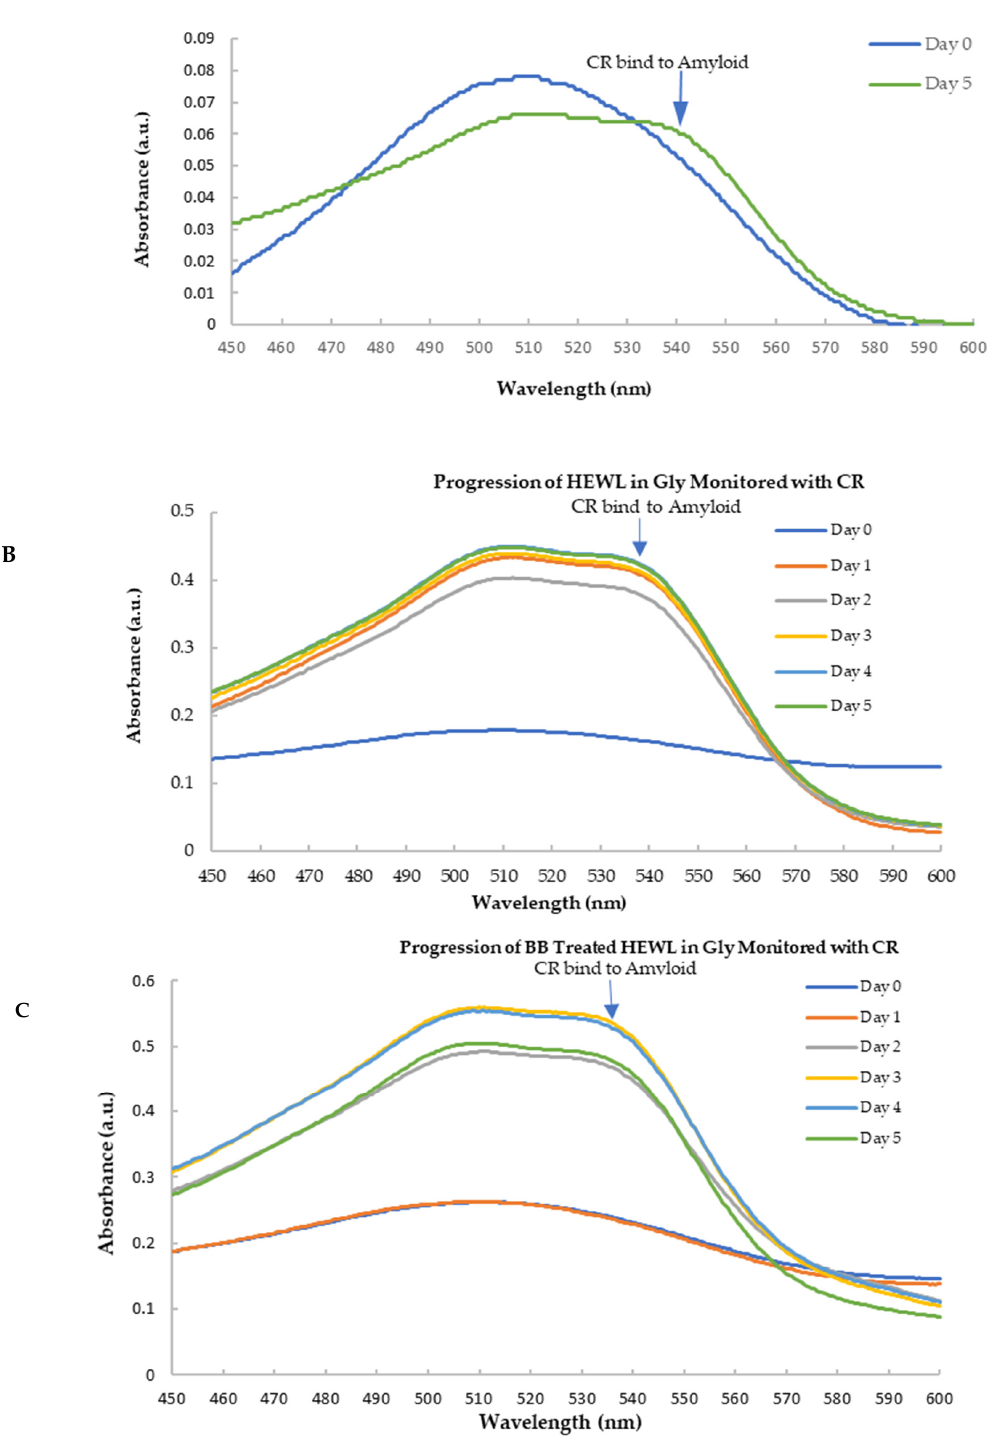
Figure 7. Spectra of CR with HEWL and blueberry-treated HEWL. ( A ) The spectra of CR with HEWL (normalized against day 0). The amyloid fibril induced a 536 nm peak in the day 5 (cid:48) s sample. ( B ) The spectra of CR with HEWL alone during 5 days; ( C ) The spectra of CR with blueberry-treated HEW during 5